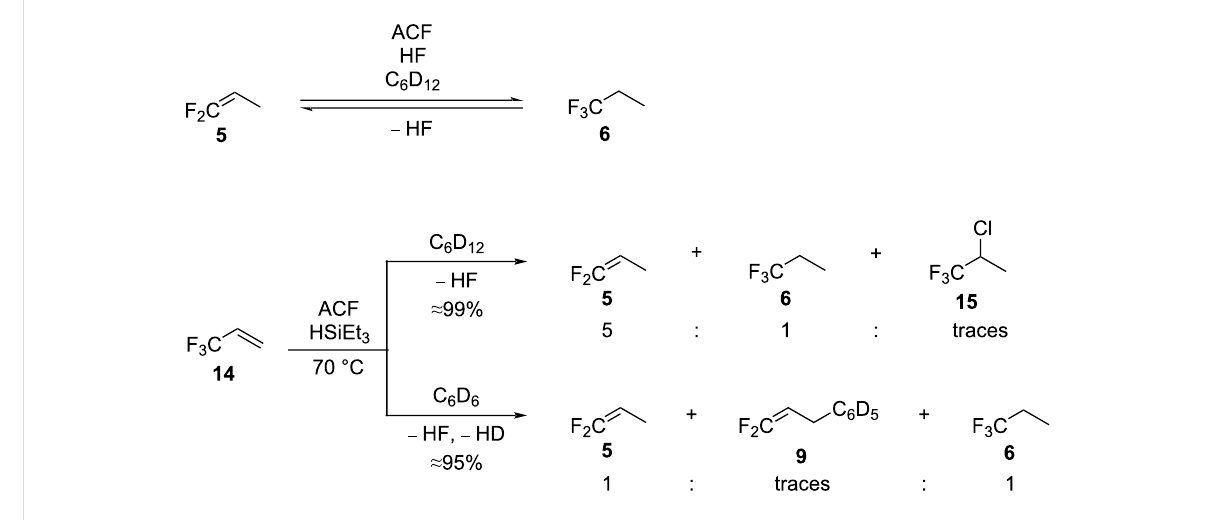
Scheme 7: Independent reactions starting from 5 , 6 , or 14 in the presence of ACF as the catalyst.